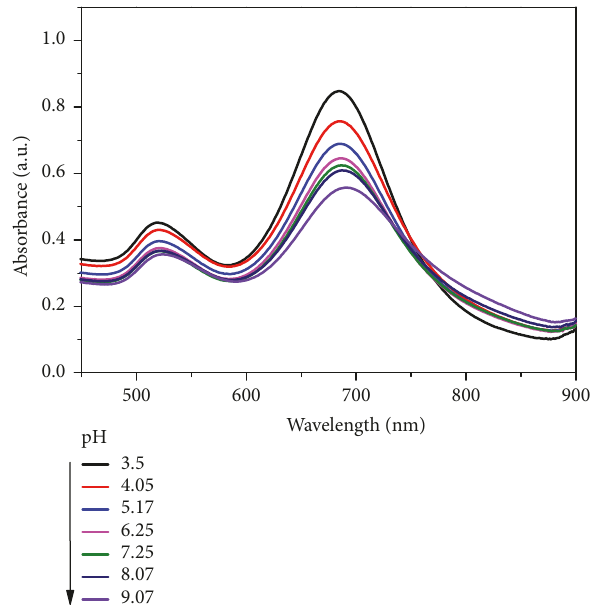
Figure 5: UV-vis absorption spectra of Au-HgNRs upon the addition of S 2− under different